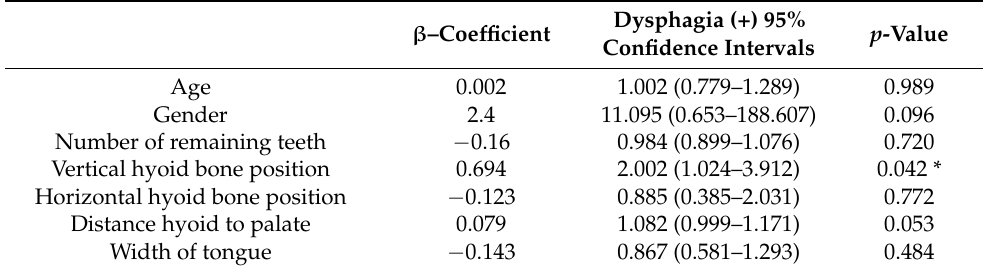
Table 5. Predictors of dysphagia (+) in a logistic regression analysis.